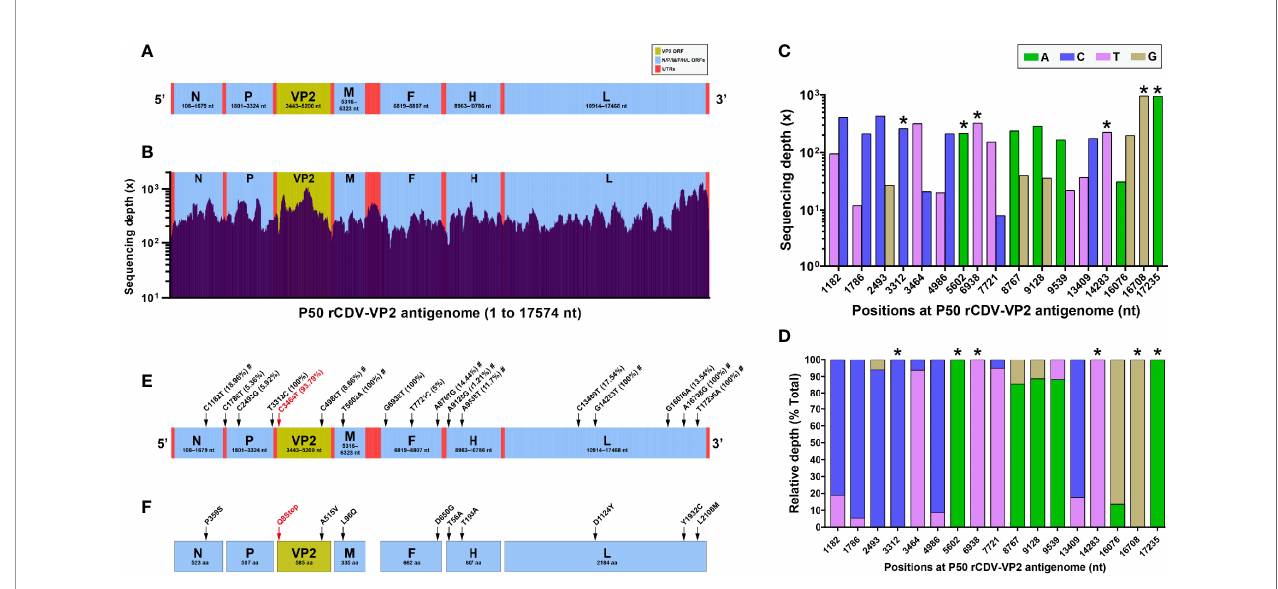
FIGURE 3 | Next-generation sequencing of P50 rCDV-VP2. Schematic representation of rCDV-VP2 antigenome (A) . All elements proportionally match their actual lengths in the viral antigenome. UTR, untranslated region. Depth and coverage of NGS across the rCDV-VP2 antigenome (B) . All genetic elements proportionally match their actual lengths in the viral antigenome. Absolute (C) and relative (D) sequencing depths for identi fi ed sites with SNM. *Mutation rate of 100% at a given site. Pro fi le of SNMs in rCDV-VP2 antigenome at P50 (E) . SNMs are marked with arrows. The sole nonsense mutation is marked with a red arrow. Numbers in brackets indicate point mutation rates. #Missense mutation. Amino acid mutations (arrow-marked) in seven proteins (F) . The sole nonsense mutation causes early termination of VP2 translation, marked with “ Q8Stop ” in